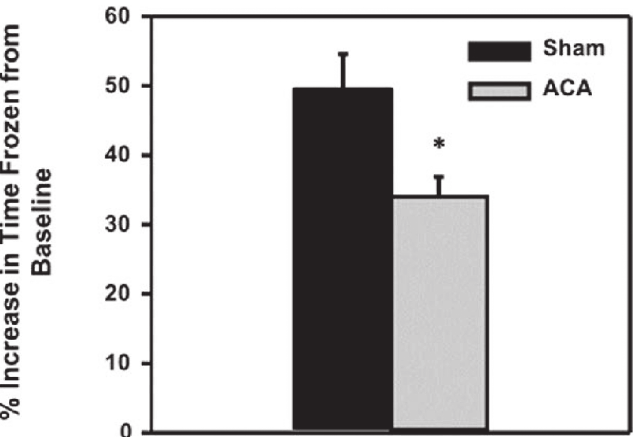
Fig 5. Fear conditioning spatial memory deficits following Sham or ACA procedure. Average increase in percent time frozen from baseline following fear conditioning was significantly higher in sham animals (51.44 ± 5.21%) compared to the ACA animals (33.97 ± 2.9%, * p < 0.05) (Sham n = 9 and ACA n = 6).